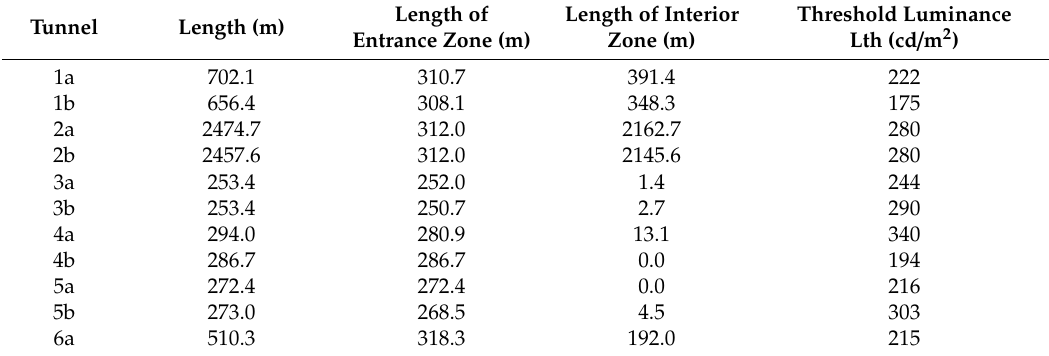
Table 1. The basic characteristics of the examined tunnels.